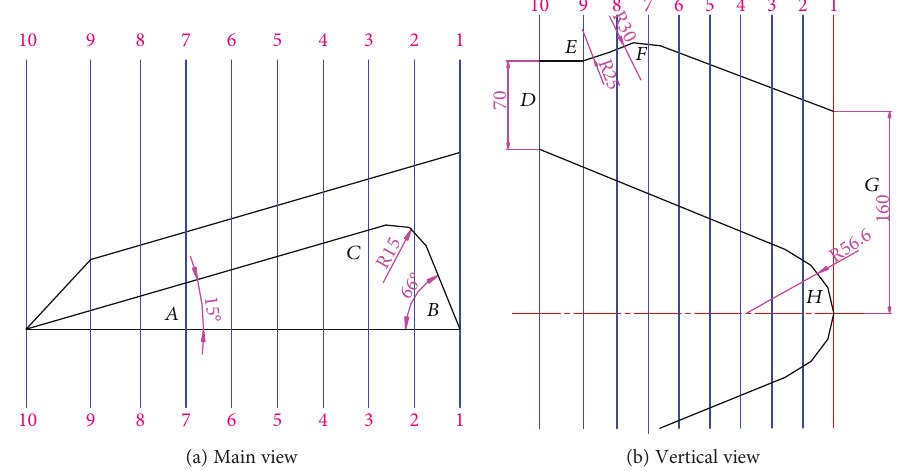
Figure 1: Structure of the head runner.